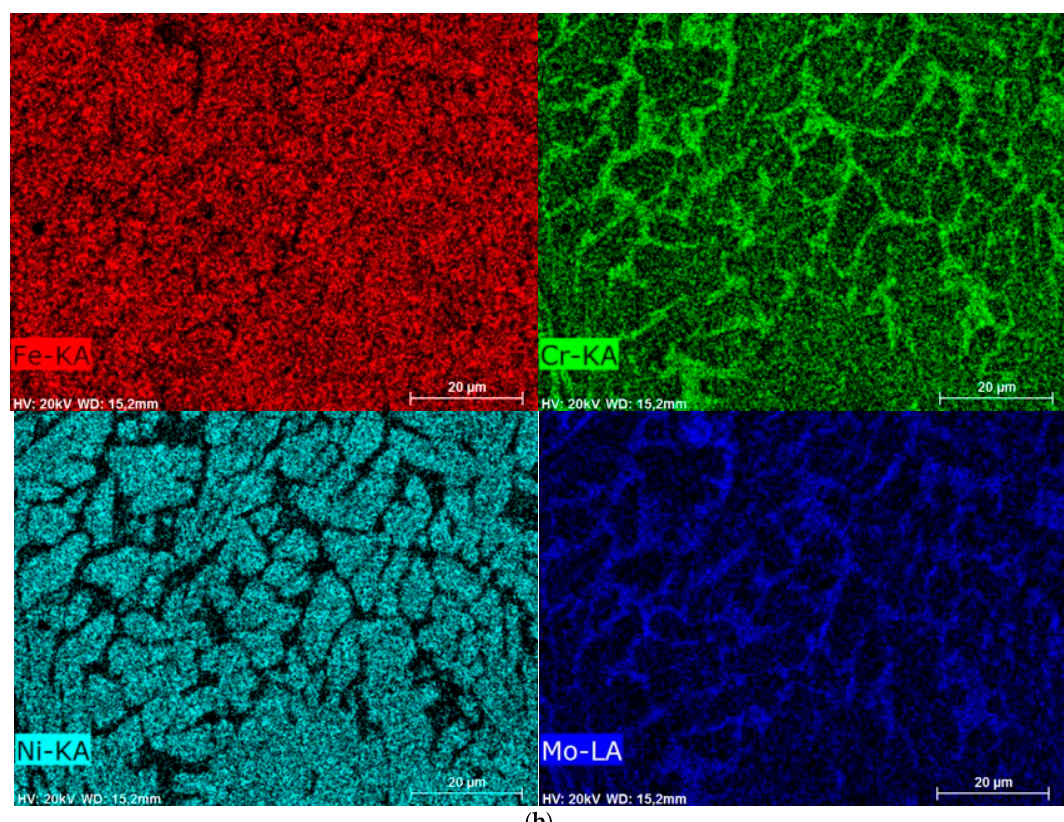
Figure 14. Sigma phase in Wall 3; ( a ) Backscattered electron (BSE) image showing the microstructure (Sigma is white), ( b ) EDX maps of Fe, Cr, Ni, and Mo.